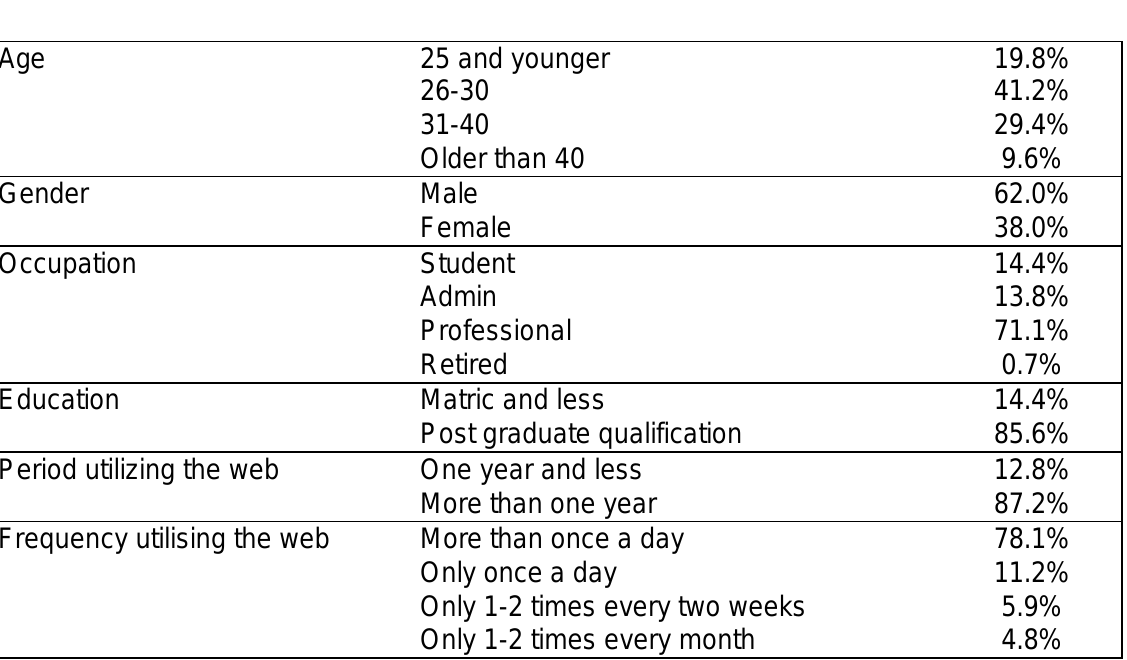
TABLE 1: PROFILE OF RESPONDENTS